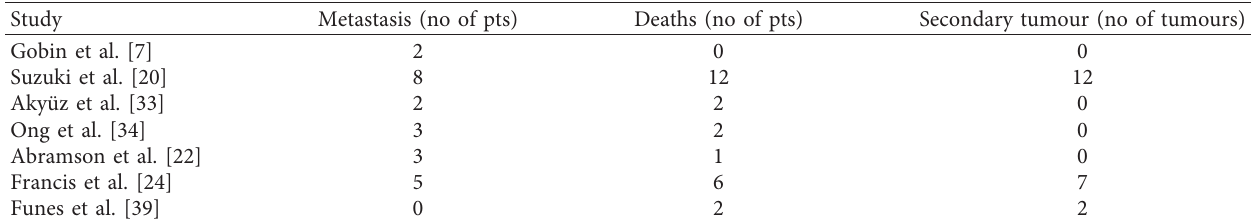
Table 6: Incidence of metastases, deaths, and secondary tumours reported in the analysed studies.